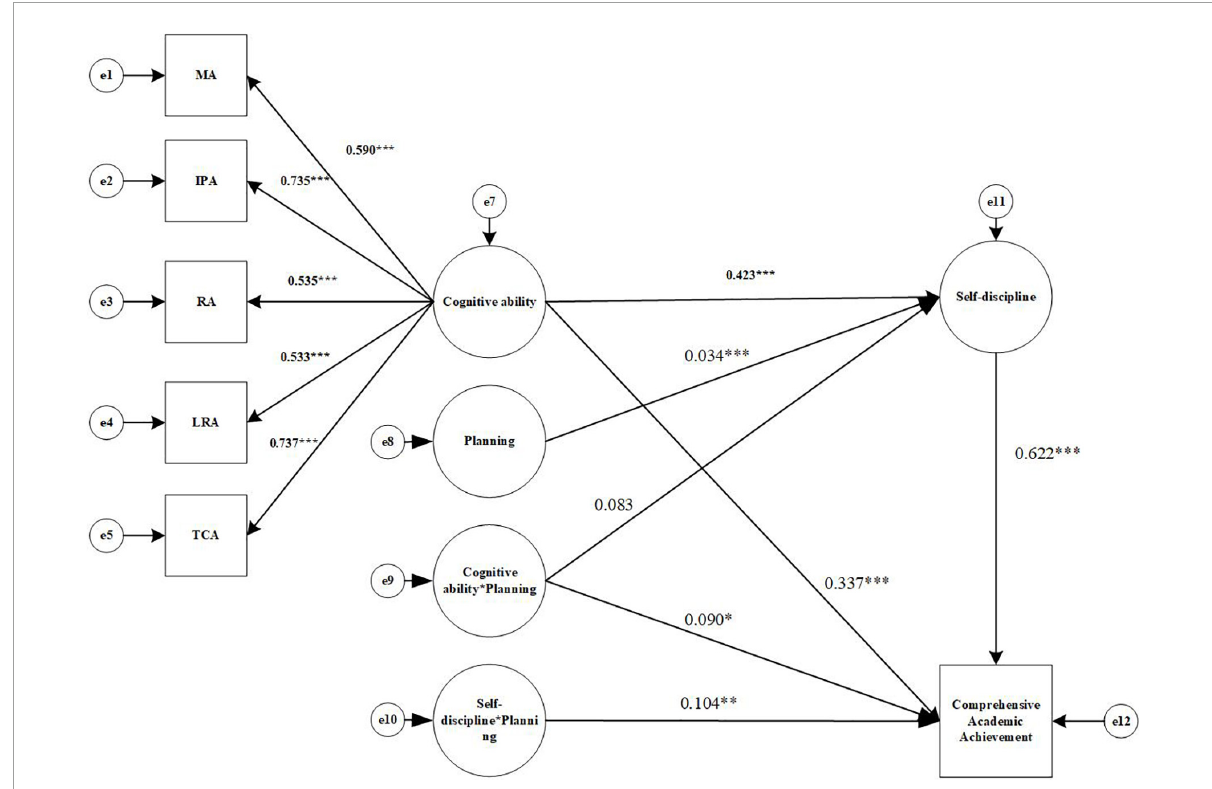
FIGURE2 Structural equation modeling results diagram (Comprehensive Academic Achievement). MA, Memory ability; IPA, Information processing ability; RA, Representation ability; LRA, Logical reasoning ability; TCA, Thinking conversion ability. ∗ p < 0.05, ∗∗ p < 0.01, ∗∗∗ p <